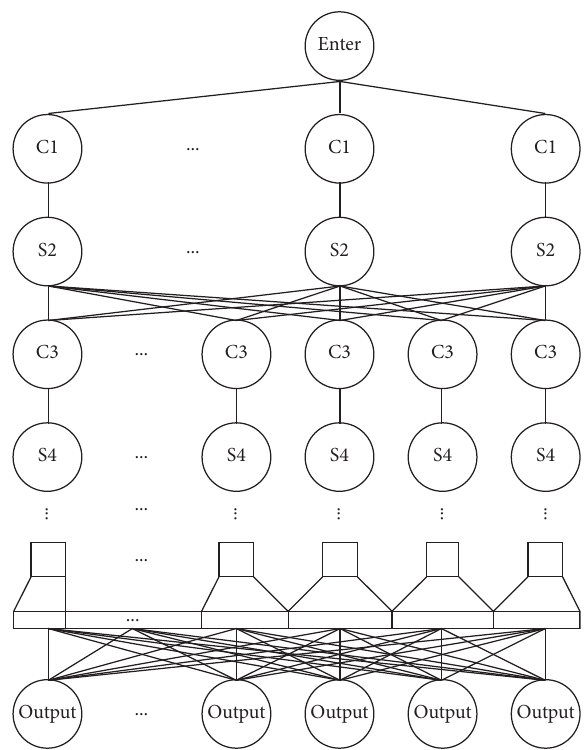
Figure 1: Deep convolutional neural network